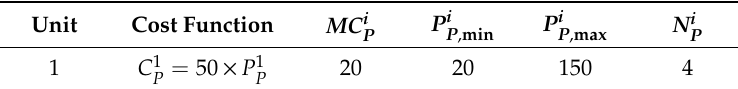
Table 1. Data of the power-only unit.